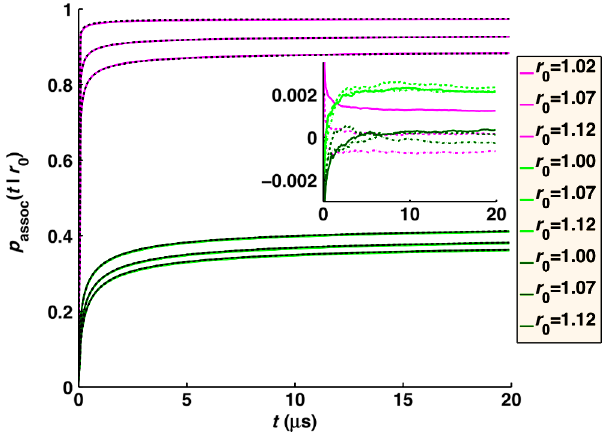
FIG. 6. Time-dependent probability of association of particle pairs for the system of Fig. 5 with Δ t ¼ 0 . 001 μ s and D 1 nm 2 = μ s, the parameter combination with the largest AB ¼ error, but now with the simulations adapted to reduce error. The RD simulations with absorbing BCs are in magenta and for k a ¼ 10 nm 3 = μ s in light and dark green, with the exact solution shown as a black dashed line. To reduce the error for these conditions, we lowered the distance over which reweighting is applied. The magenta lines are simulations with the reweighting separation ffiffiffiffiffiffiffiffiffiffiffiffi ffiffiffiffiffiffiffiffiffiffiffiffi p p 6 D Δ t 6 D Δ t decreased from 3 to 1 . 4 , but with the same reaction zone size. This means trajectories are reweighted for a shorter length of time. The light green lines are for k a ¼ 10 nm 3 = μ s and the reweighting separation decreased from ffiffiffiffiffiffiffiffiffiffiffiffi ffiffiffiffiffiffiffiffiffiffiffiffi p p 3 6 D Δ t 6 D Δ t to 1 . 7 . Another way to reduce error is to simply increase k a , and in dark green we show association for k a increased from 10 to 10 . 3 nm 3 = μ s. This approach is not appli- cable to absorbing BCs ( k a cannot be increased) but works well for finite rates. The inset shows the difference between exact and simulated